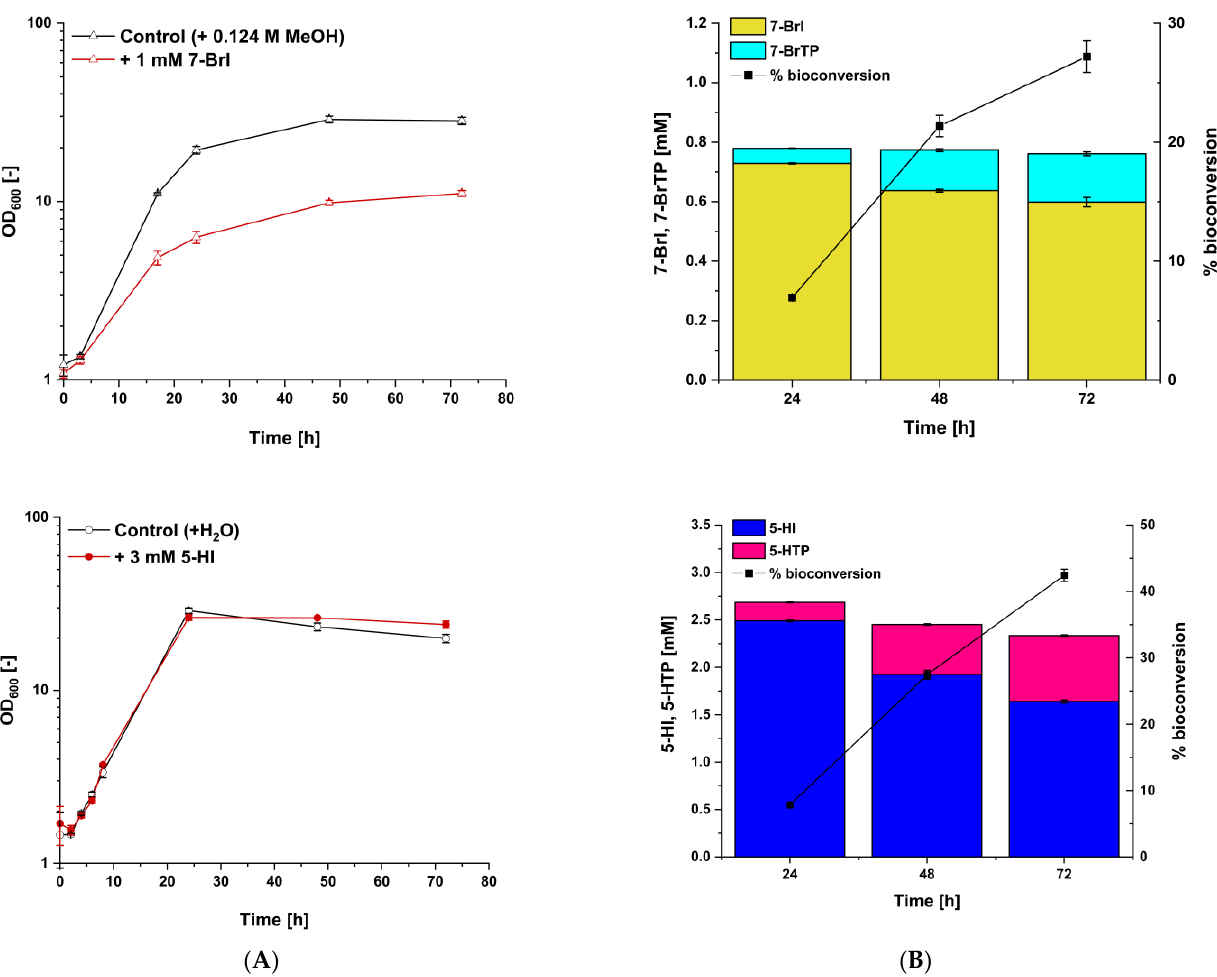
Figure 6. Growth ( A ) and production ( B ) of L -tryptophan derivatives in shake flask. Values and error bars represent means and standard deviations from 3 replicate cultivations with supernatants analyzed at indicated time points for HPLC. As a control, either water (solvent of 5-HI) or 0.124 M MeOH (solvent of 7-BrI) was used. Error bars indicate the standard deviations of the means of three replicates.